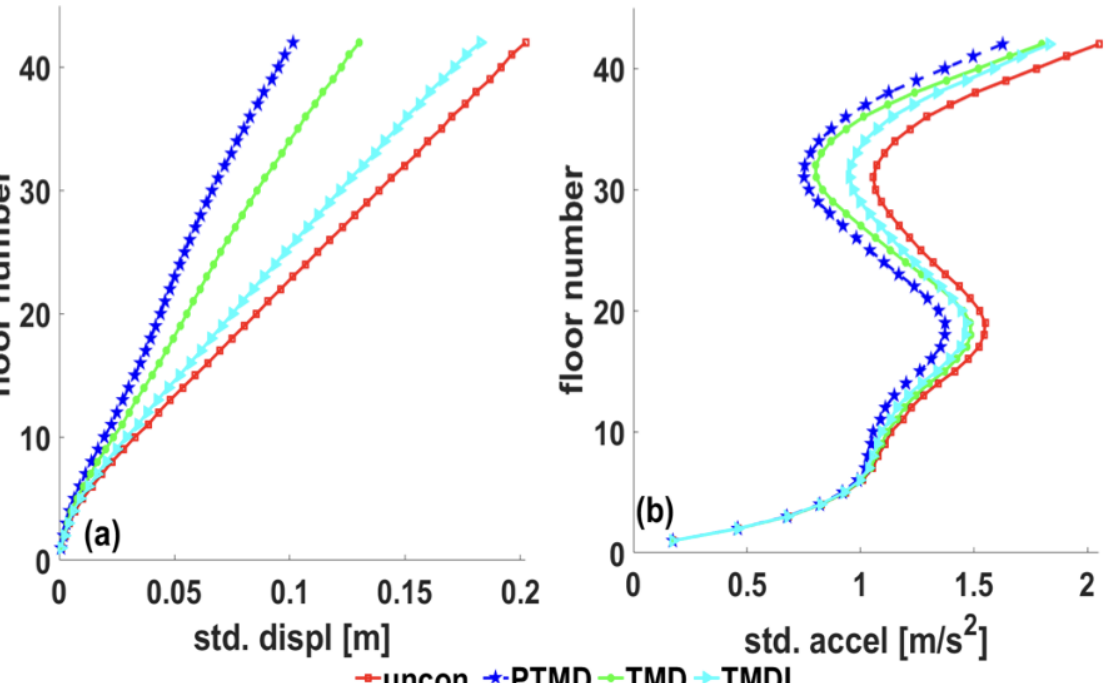
Figure 18. Floorwise responses under El-Centro earthquake: ( a ) STD displacement, ( b ) STD acceler- ation.